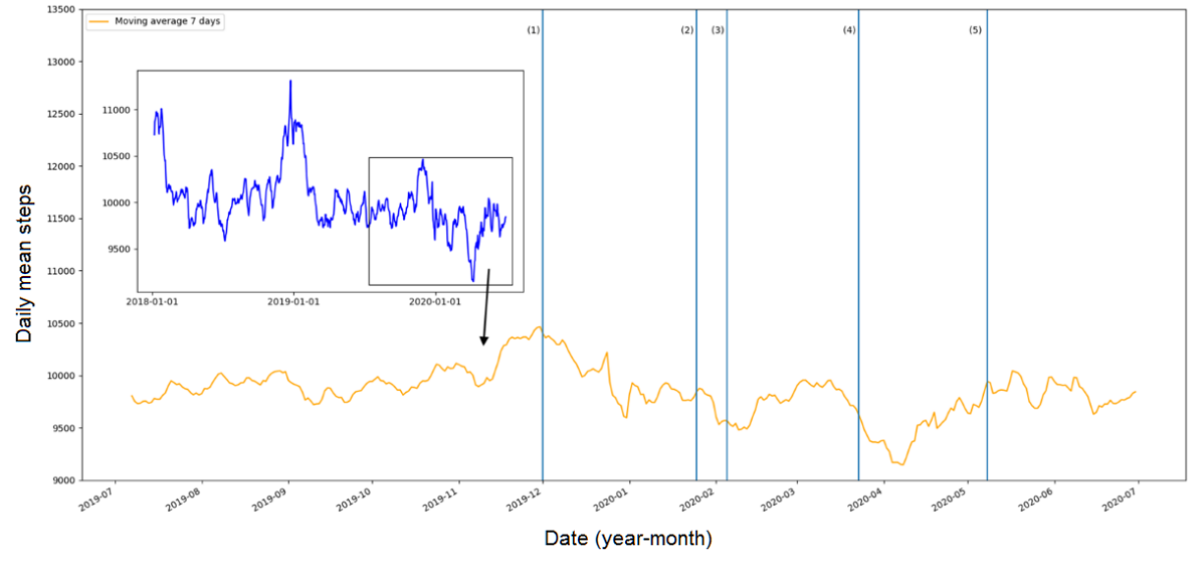
Figure 1. Daily mean steps over time and key COVID-19 pandemic events. (1) First case with symptoms in Wuhan, China; (2) First case in Australia reported; (3) A 14-day ban for noncitizens arriving in Australia from China implemented; (4) Lockdown starts in Australia; (5) Australian Government starts relaxing restrictions.